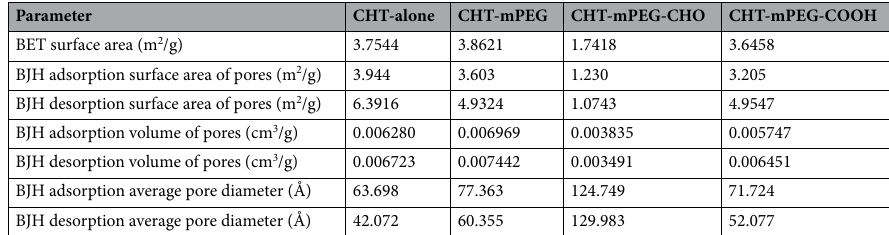
Table 4. Surface area and porosity characteristics of the various cryosponges.